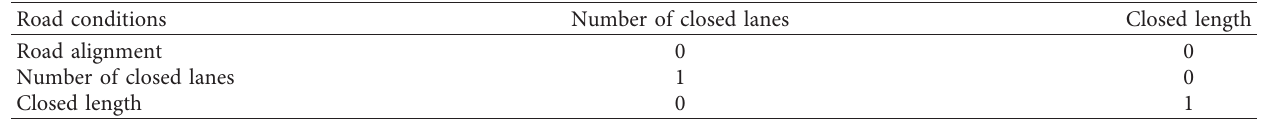
Table 3: Dummy variable assign transform of road conditions.